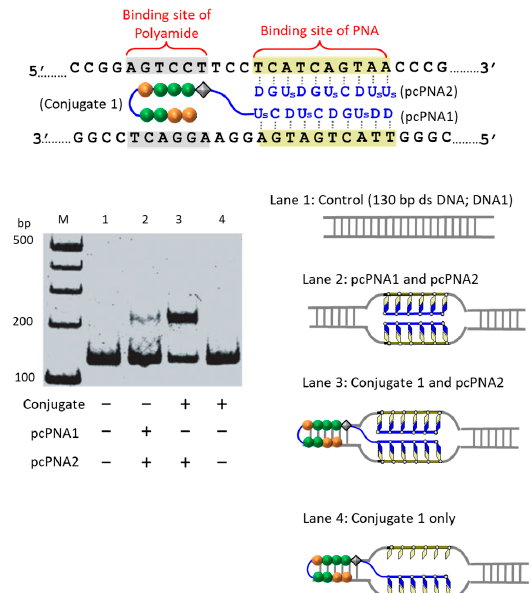
Figure 5. Gel-shift assay for binding of the pcPNA-polyamide conjugate and complementary pcPNA to dsDNA. The pcPNA (blue) binds to 5 ′ -TCATCAGTAA-3 ′ and the polyamide (orange and green balls) bind to 5 ′ -AGTCCT-3 ′ in the DNA1. Lane 1, DNA only; lane 2, DNA with two pcPNA strands without the polyamide; lane 3, DNA with the combination of the pcPNA-polyamide conjugate and complementary pcPNA; lane 4, the conjugate only; M, 100 bp ladder. Invasion conditions: [DNA] = 10 nM, [Conjugate 1] = 100 nM, and [pcPNA] = 100 nM at pH 7.0 and 50 °C for 24 h.